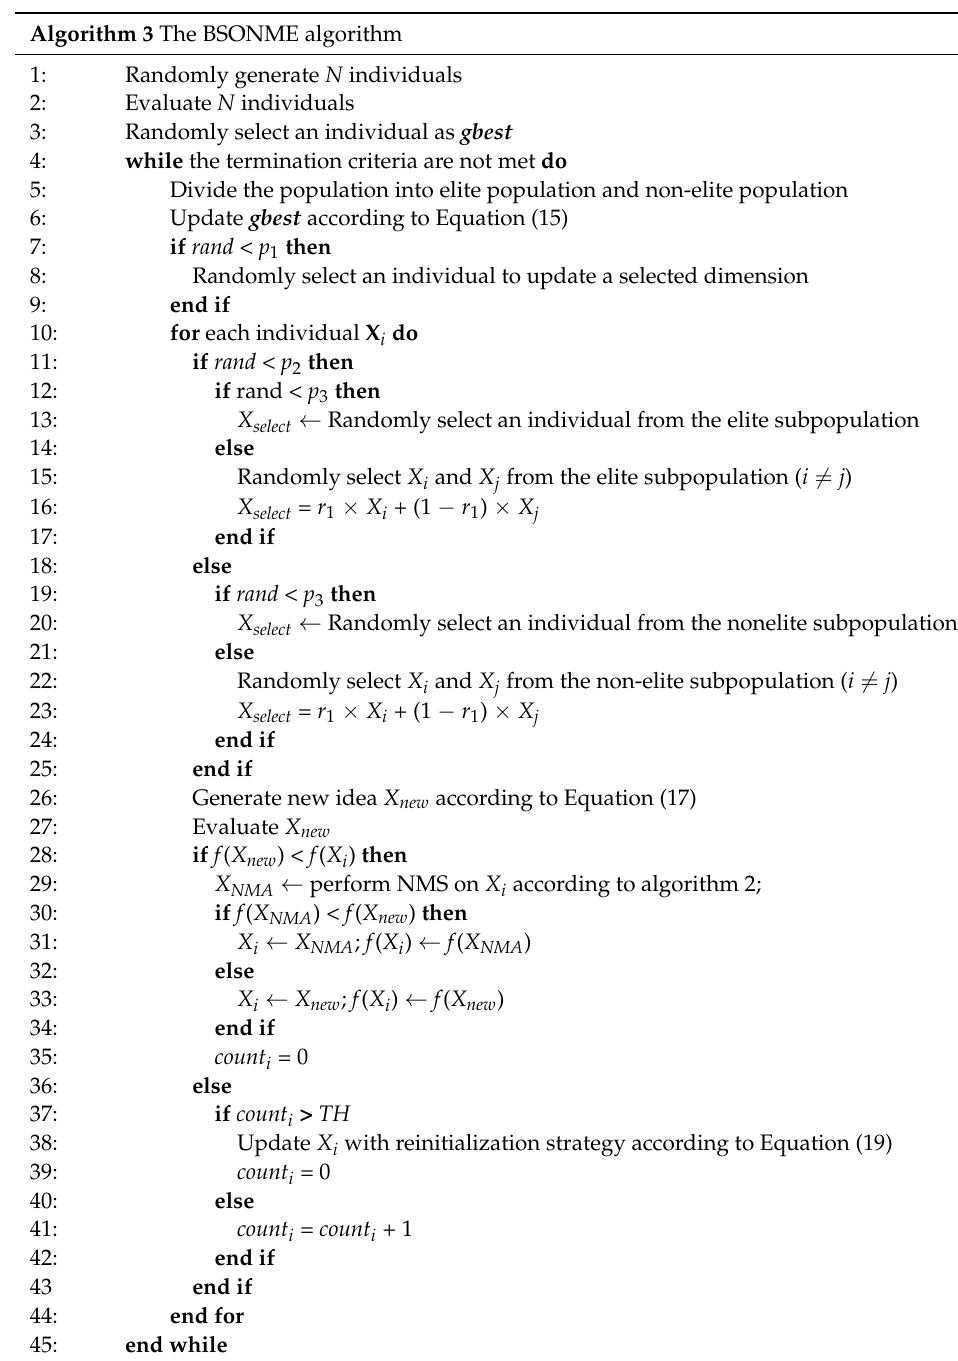
Algorithm 3 The BSONME